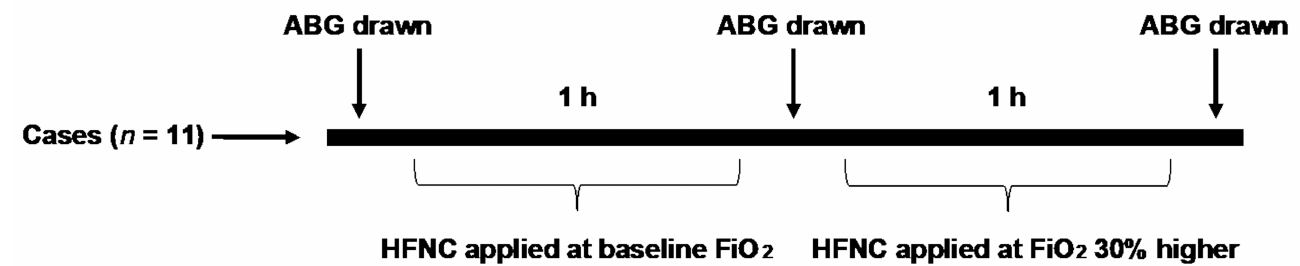
Figure 2. Schematic study design. After baseline ABG (arterial blood gas) was obtained on the patient’s supplemental oxygen (or room air if the patient used oxygen with exertion), subjects were placed on HFNC with an FiO 2 equal to their baseline supplemental level and a flow rate of 30 L/min. After 1 h of clinical monitoring, a second ABG was drawn. FiO 2 was then increased by 30% and the patient underwent a second hour of clinical monitoring, at the completion of which a third ABG was